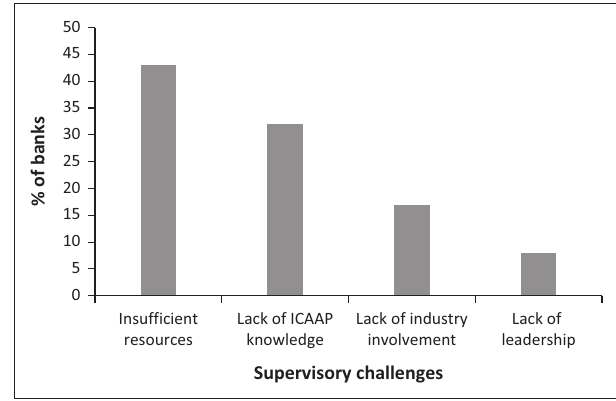
FIGURE 6: The main reasons for supervisory challenges.